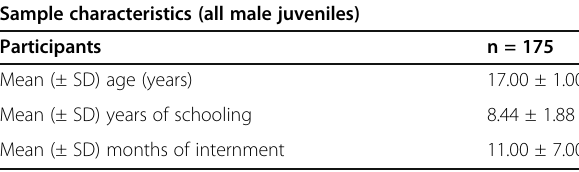
Table 1 Demographic characteristics of participants Sample characteristics (all male